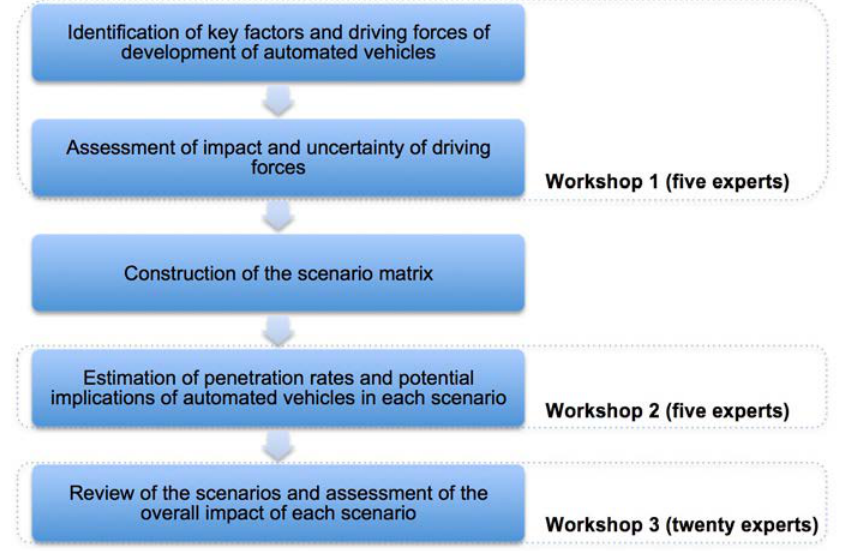
Figure 1. The five steps for the construction and assessment of scenarios about development and implications of automated vehicles in the